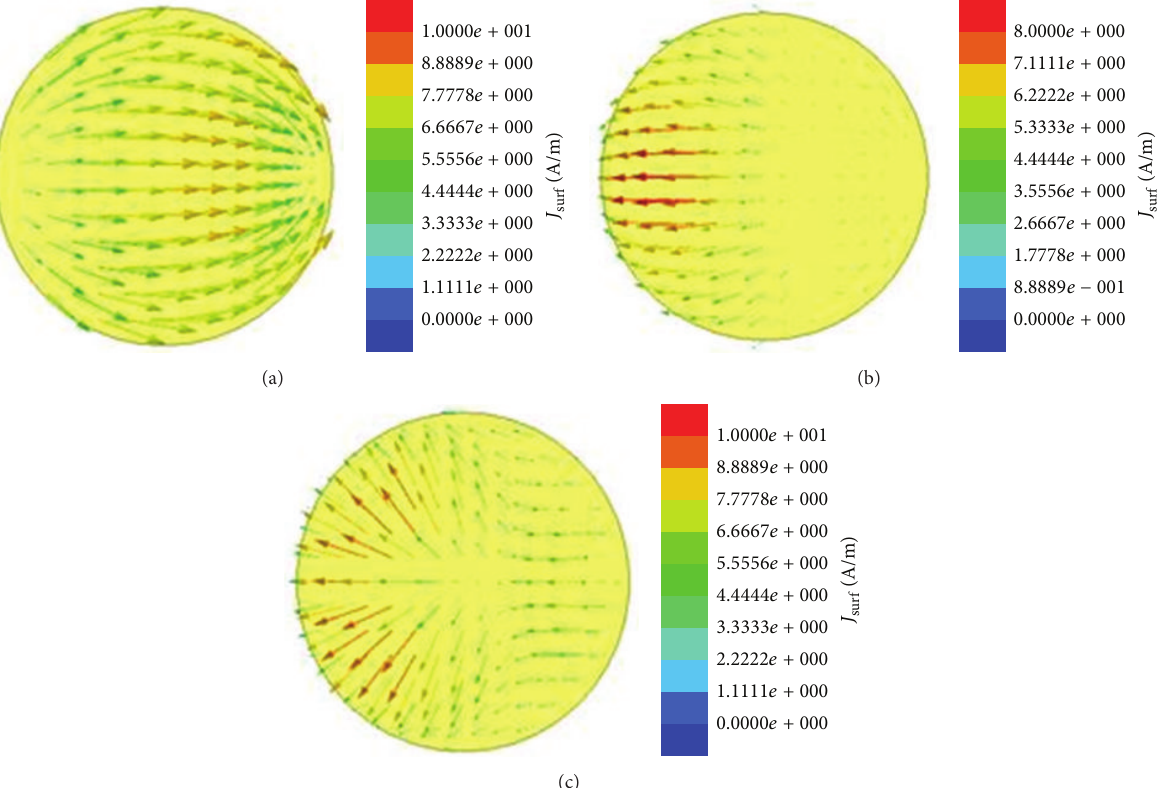
Figure 4: Current distribution of the metal (PEC) coating. (a) 3.0 GHz, (b) 5.0 GHz, and (c) 6.5